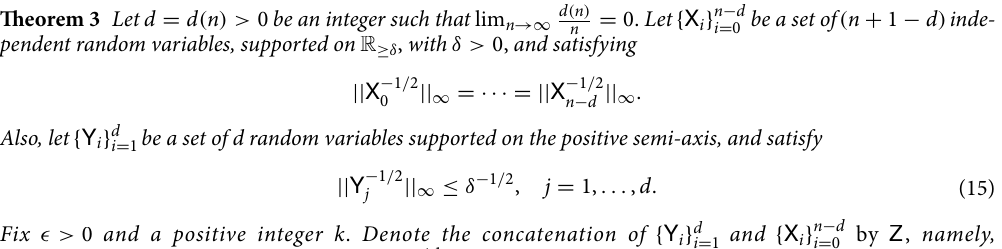
Figure 4. Histograms of 10, 000 R n values in Example 4 for n The theory predicts that as n